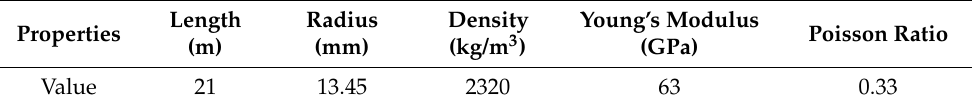
Table 2. Parameters of the wire.